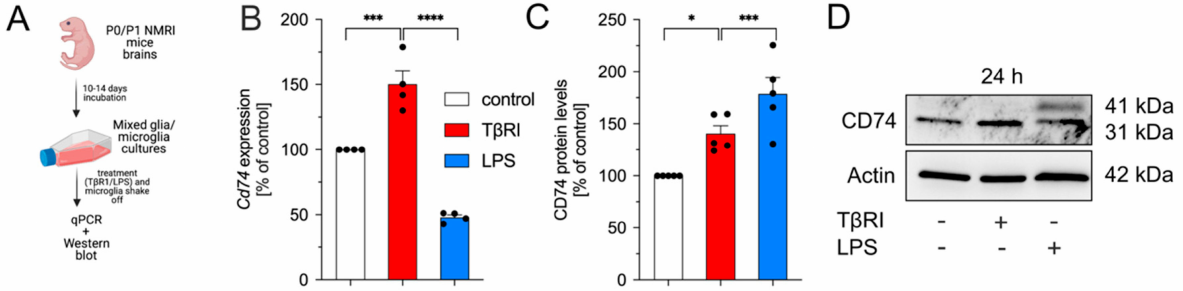
Figure 4. Inhibition of TGF β signaling increases expression of Cd74 in mixed glia cultures. ( A ) Scheme of experimental workflow, created with BioRender.com. ( B ) Expression of Cd74 after treatment of mixed glia cultures with T β RI (500 nM) or LPS (1 µ g/mL) for 24 h. ( C ) Quantifications of CD74 total protein levels after treatments for 24 h. ( D ) Representative western blot images for the analyzed experimental time point. Data are given as means ± SEM for at least four independent experiments. p -values derived from one-way ANOVA followed by Tukey’s multiple comparison tests are shown as follows: * p < 0.05, *** p < 0.001, and **** p <